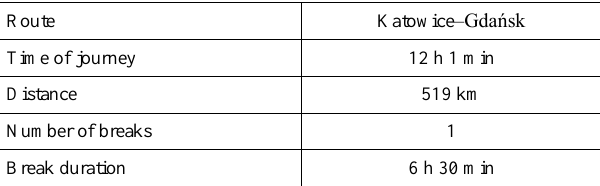
Table 10. Route details generated for Nissan Leaf